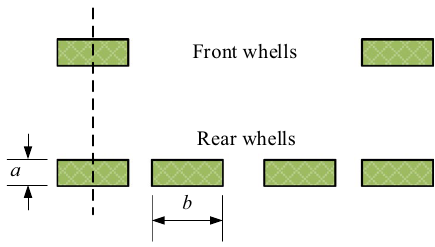
Fig. 2 Calculation diagram of wheel-to-ground contact area during mining haul truck